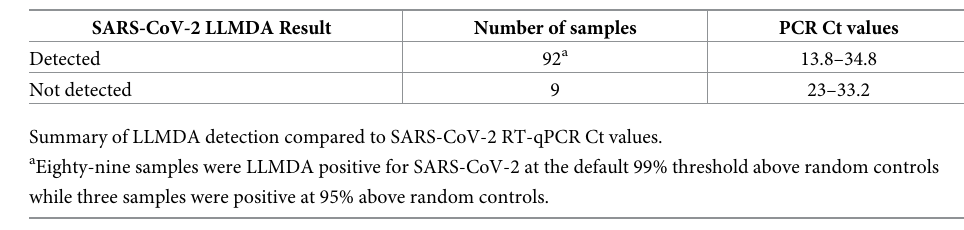
Table 2. SARS-CoV-2 detection